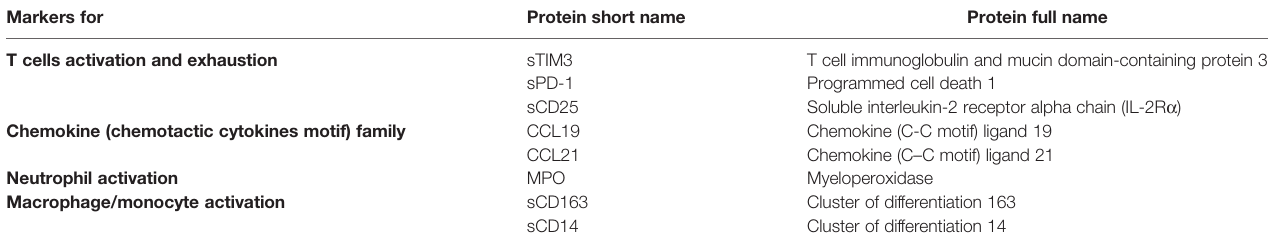
TABLE 1 | Markers included in the study. Markers